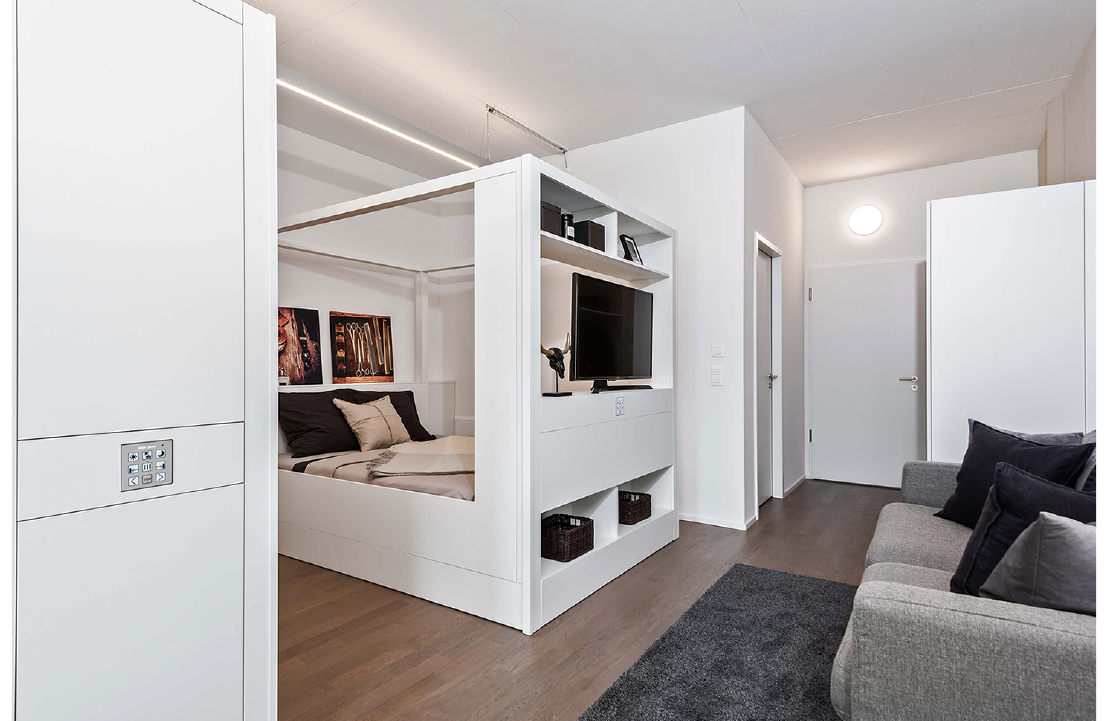
Figure 9. Halter, flexible MOVEment system, removable furniture in the living room-bedroom. Image courtesy of Halter.